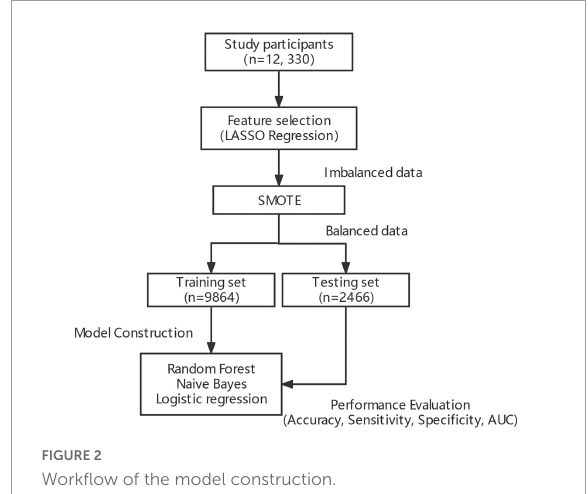
FIGURE2 Workflow of the model construction.